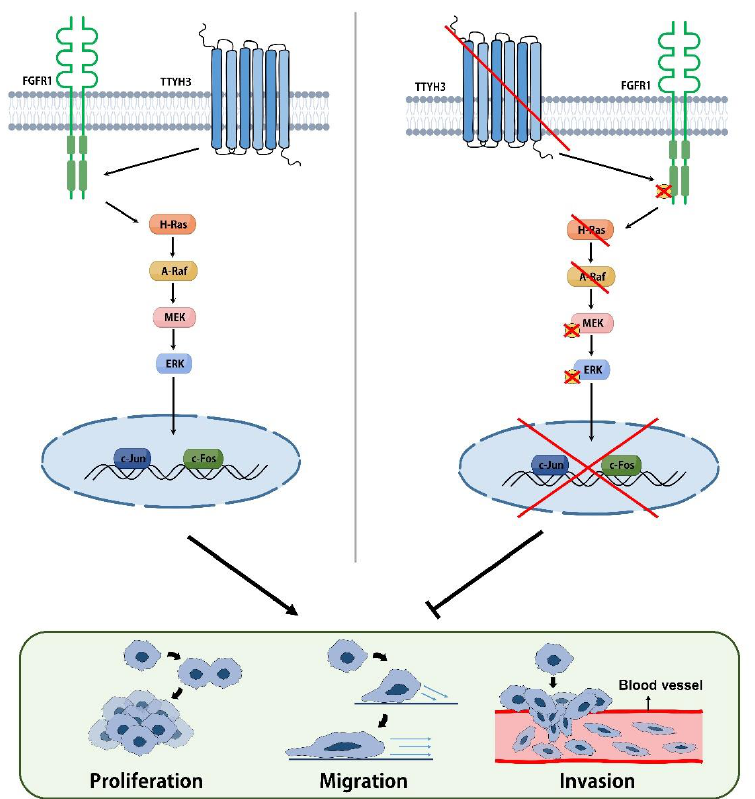
Figure 5. Schematic diagram of the proposed role of TTYH3 in bladder cancer. TTYH3 knockdown regulates cell proliferation, migration, and invasion by inhibiting FGFR1 and MAPK signaling.